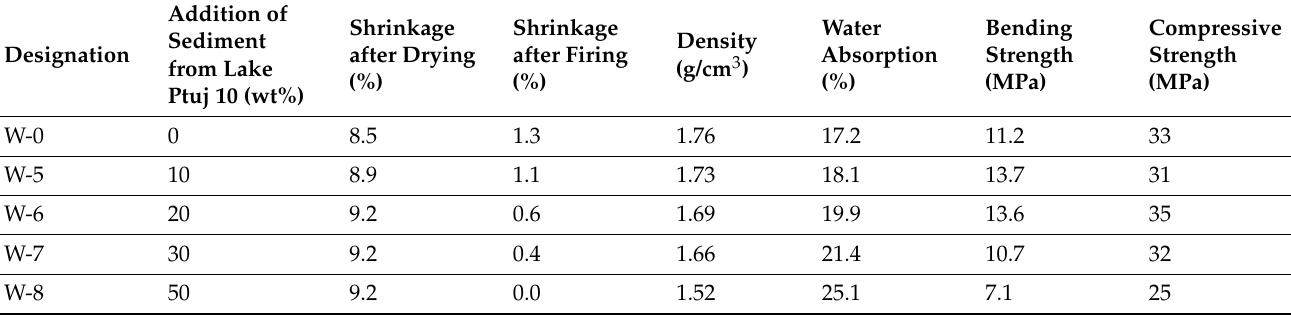
Table 3. Properties of the dried and fired samples.